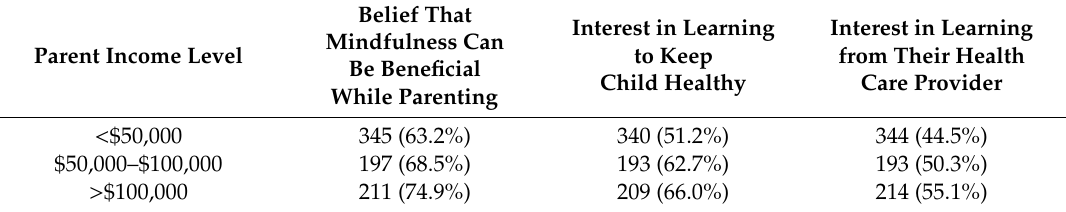
Table 3. Endorsement of mindfulness (agree / strongly agree) by parents of children with asthma by income